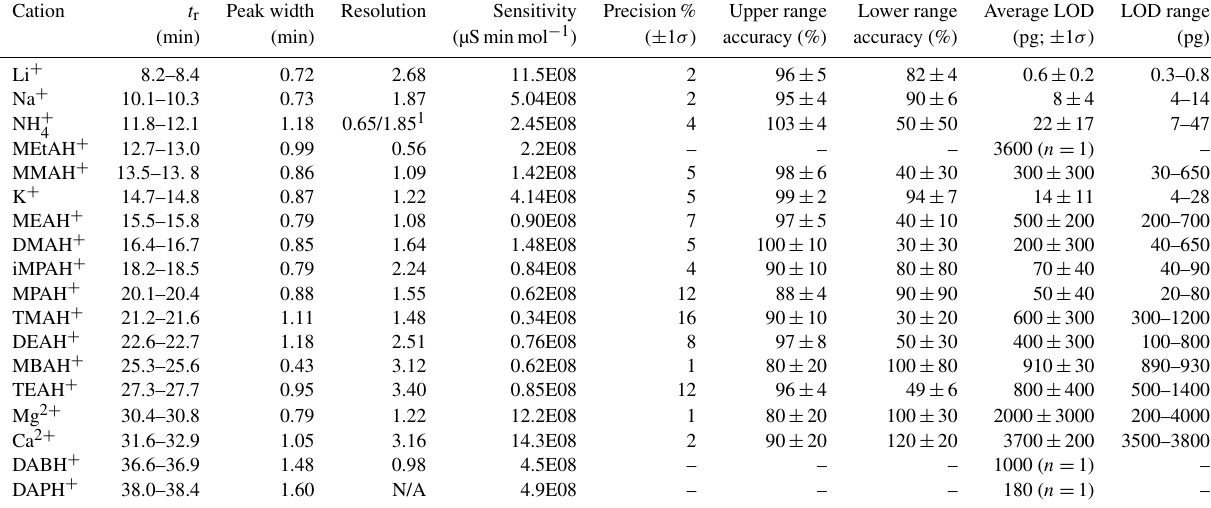
Table 1. Separation characteristics and statistics for the CS19 gradient method. The retention time ( t r ) ranges for the methylamines, ethy- lamines, and inorganic cations were determined using retention time windows from a full calibration. The peak width and resolution were determined using the highest calibration standards for amines (500ng) and inorganic (160–520ng) cations. The t r range and peak width were back-calculated for iMPAH + , MPAH + , MBAH + , DABH + , and DAPH + based on the other alkylamine responses to column degradation. Sensitivity, precision, average LOD, and LOD range were analyzed using multiple calibration standards and blanks (see Sect. 2.4). Upper and lower range accuracies were assessed using high and low check standards for the alkylamines ( n = 6) and inorganic cations ( n = 4). The low check standards were 15 times more concentrated than the lowest calibration standard and the high check standards were 150 times more